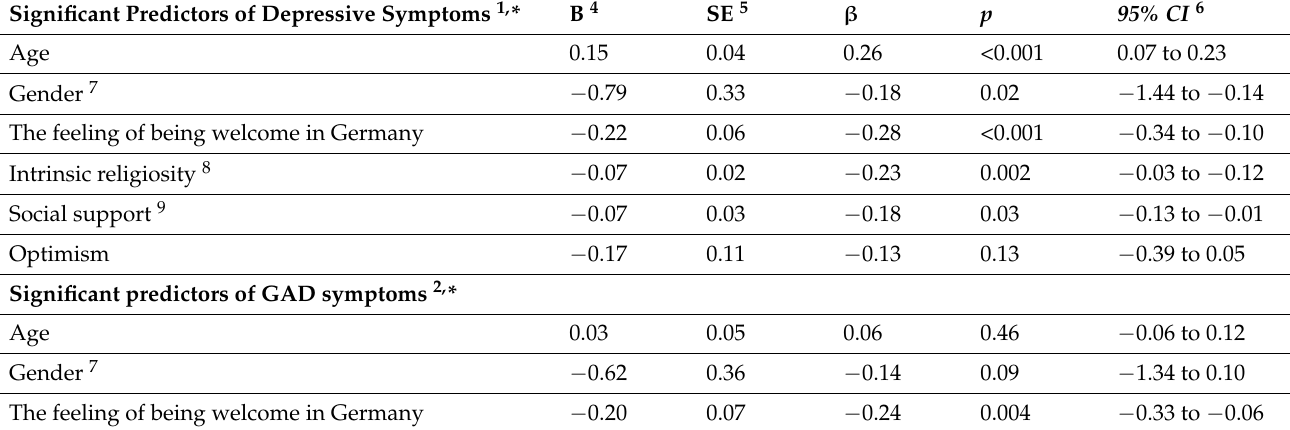
Table 3. Multiple linear regression analyses for depression, generalized anxiety and PTSD symptoms as dependent variables (N =